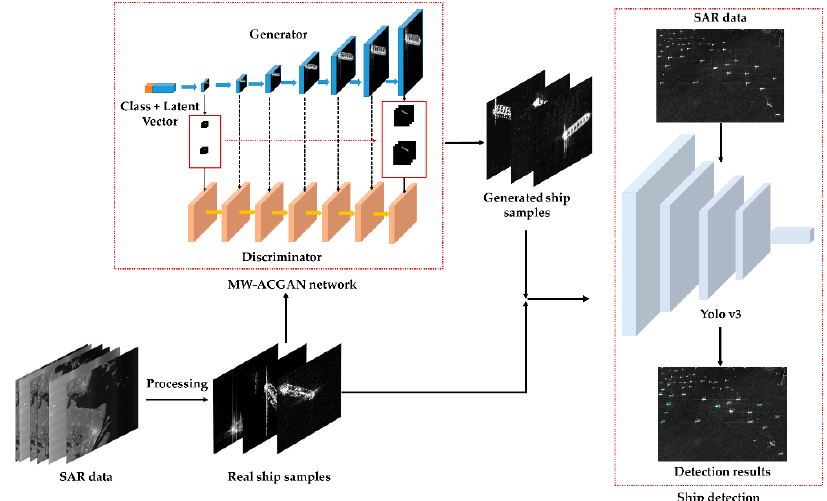
Figure 1. Research flow chart.